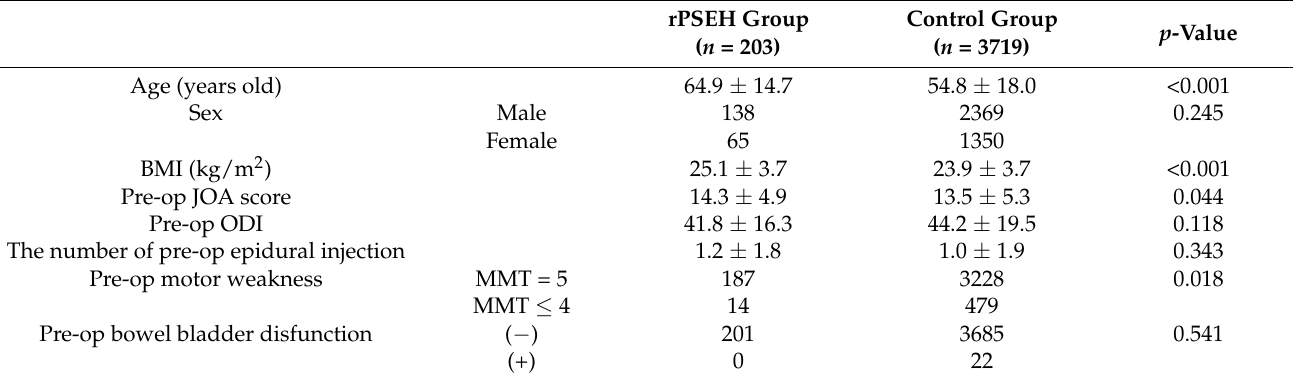
Table 2. Comparison of patients’ demographic data between the patients with and without rPSEH.